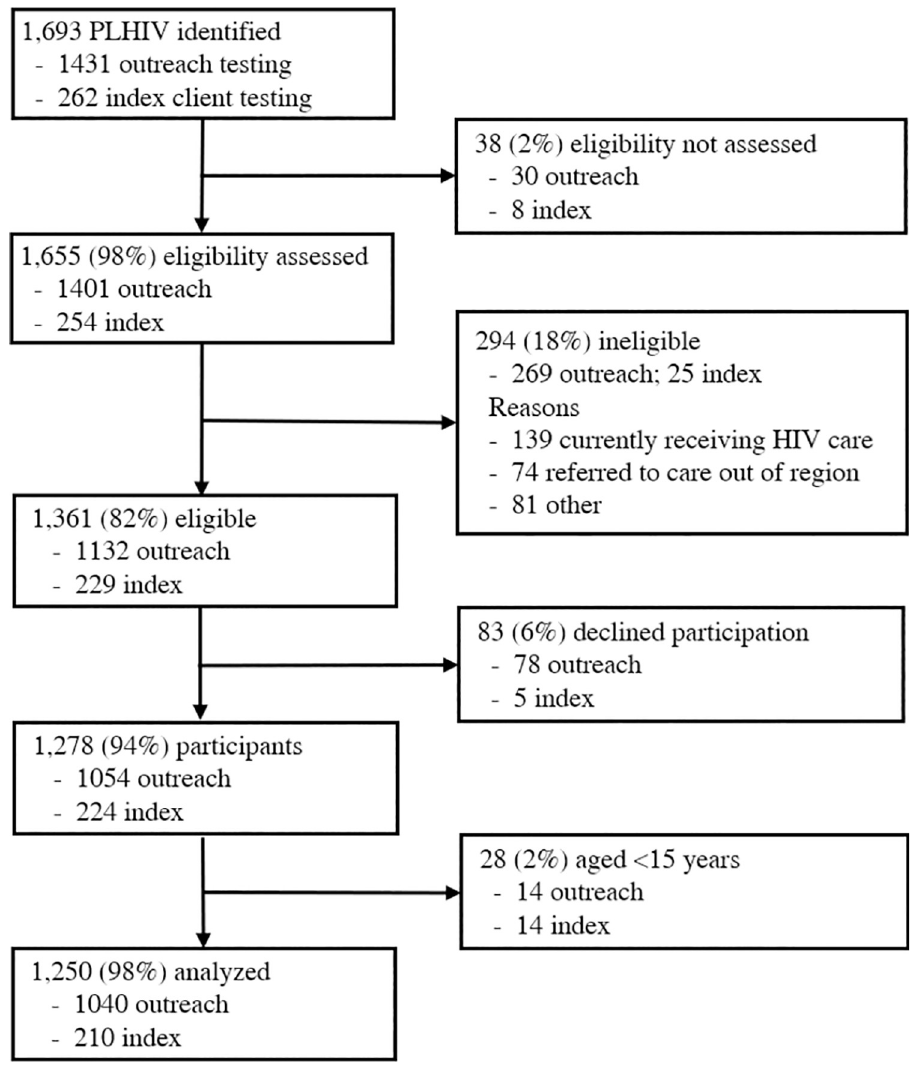
Fig 1. CommLink outreach and index client testing participation